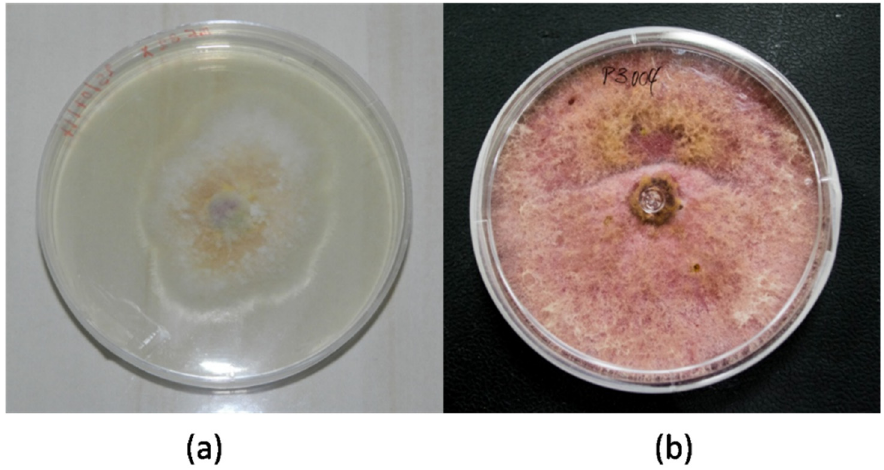
Figure 3. Fusarium specimens: ( a ) F. oxysporum MF32-MH455293 and ( b ) F. equiseti MF18-MH455291.